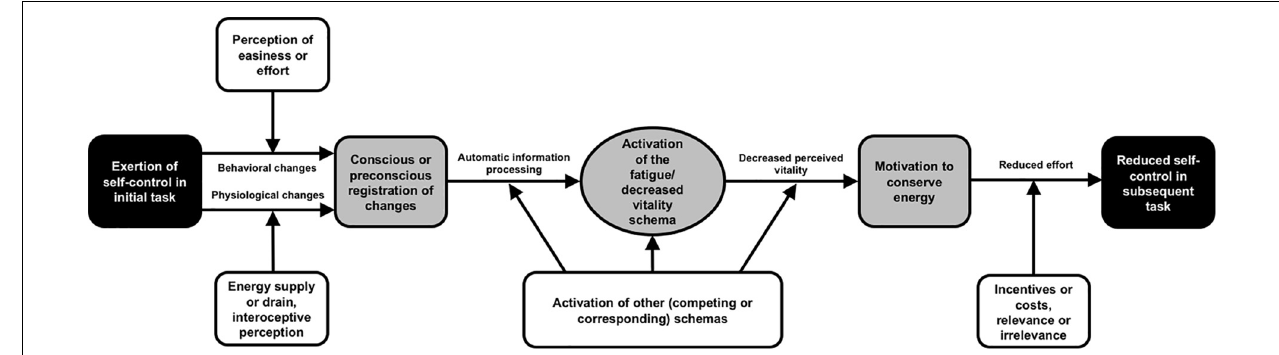
FIGURE 1 | The schema model of self-control to explain the ego depletion effect. Black boxes: the observable behavior in ego depletion studies. Gray boxes and horizontal arrows: the mediating processes within the individual. White boxes: moderating variables.